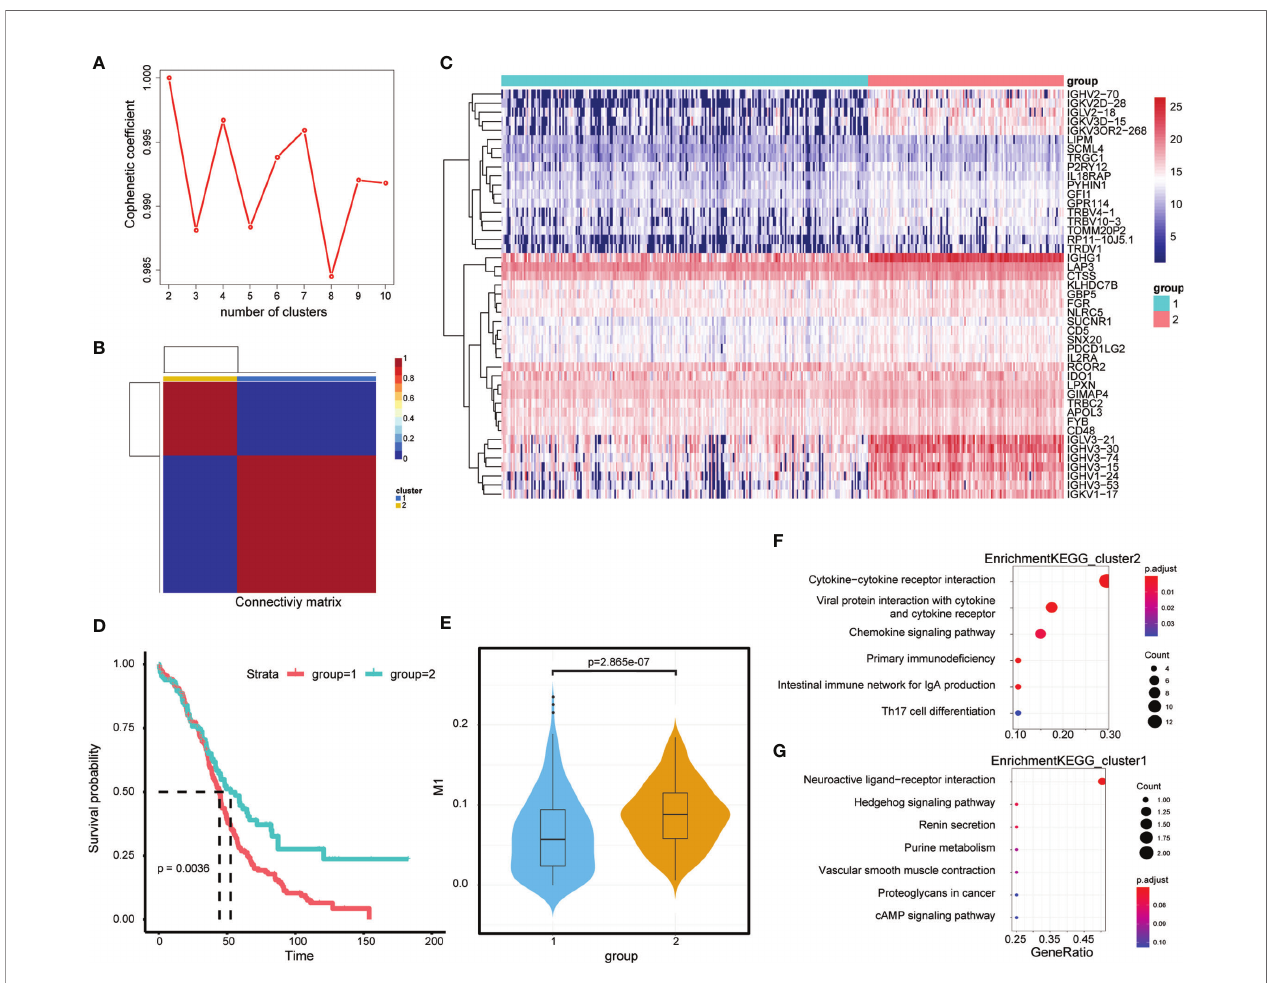
FIGURE 6 | M1-related Molecular typing. (A) Consensus Map of NMF Clustering. (B) Sample cluster of TCGA-OC. (C) Expression of relating genes in M1 like myeloid cells. (D) Kaplan-Meier curves of two OC molecular subtypes. (D) Proportion of M1-like myeloid cells in two OC molecular subtypes. (E) KEGG functional enrichment analysis of differential genes in two OC molecular subtypes. (F, G) KEGG functional enrichment analysis of differential genes in two OC molecular